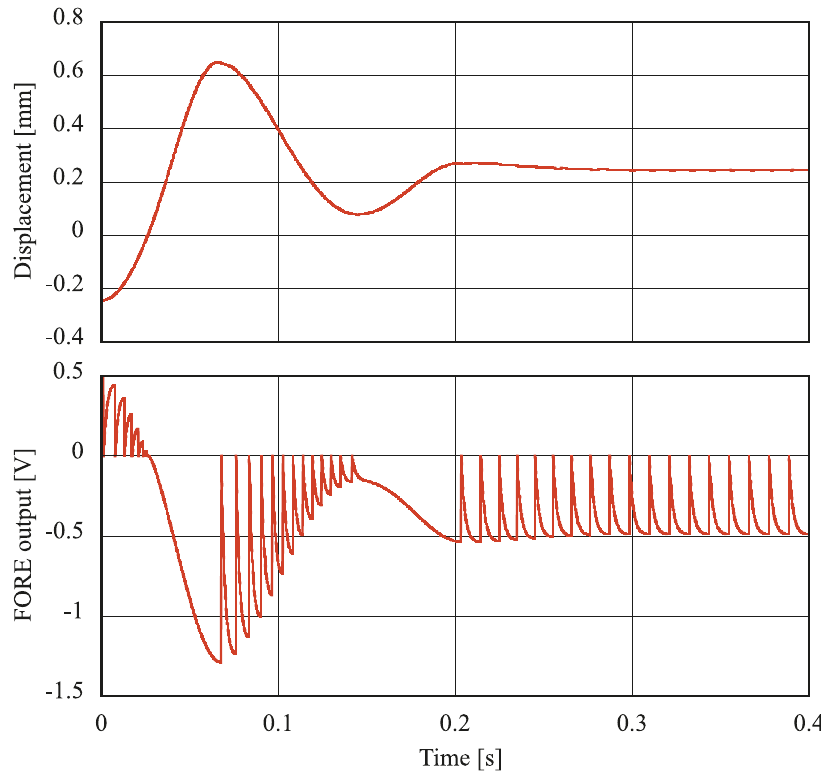
Figure 11. Time histories after the rising of disturbance. The top represents the displacement of the floator, and the bottom represents the FORE output.